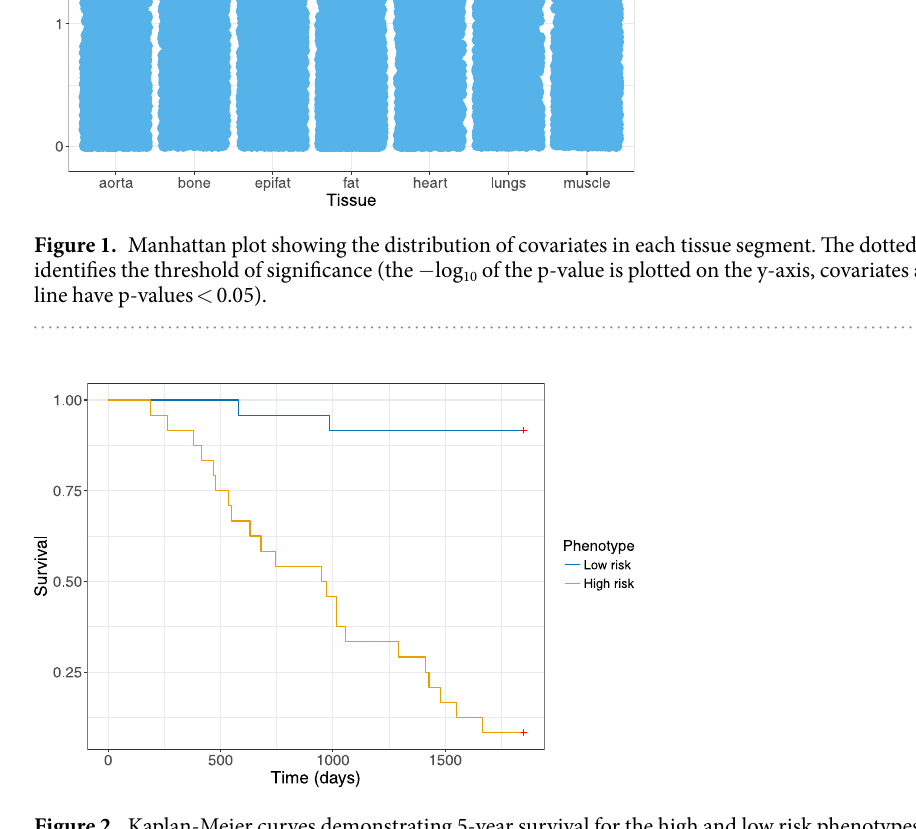
Figure 2. Kaplan-Meier curves demonstrating 5-year survival for the high and low risk phenotypes developed using human engineered image features extracted from CT chest scans. There were two mortalities for the twenty five patients identified to be low risk, and twenty mortalities amongst the twenty three patients identified as high risk. The difference between curves is significant (p <